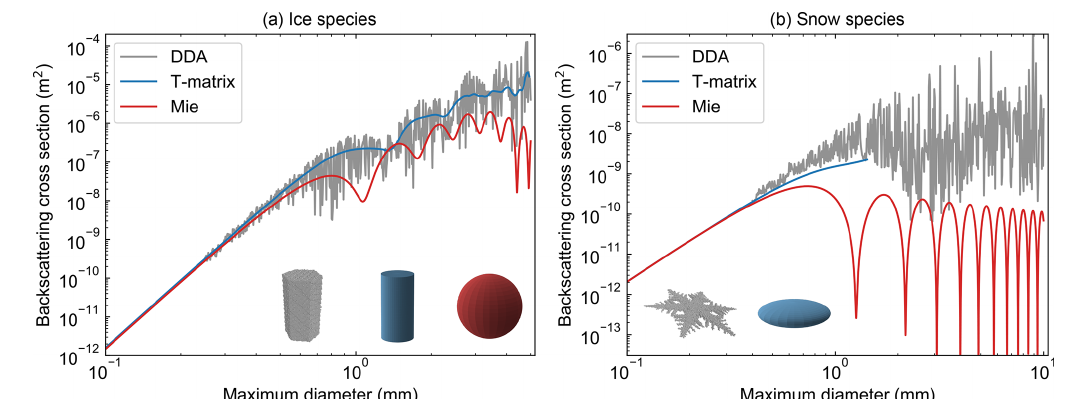
Figure A1. Comparison of DDA, T-matrix, and Mie backscattering cross-section calculations for the two solid-phase hydrometeor species described in this work. The ice (a) and snow (b) species are treated as hexagonal columns and pristine dendrites for DDA calculations and as cylinders and oblate spheroids for the T-matrix approach, respectively. For the snow T-matrix calculations, a maximum diameter greater than 1.5mm results in a spheroid aspect ratio that is beyond the convergence criteria for the T-matrix